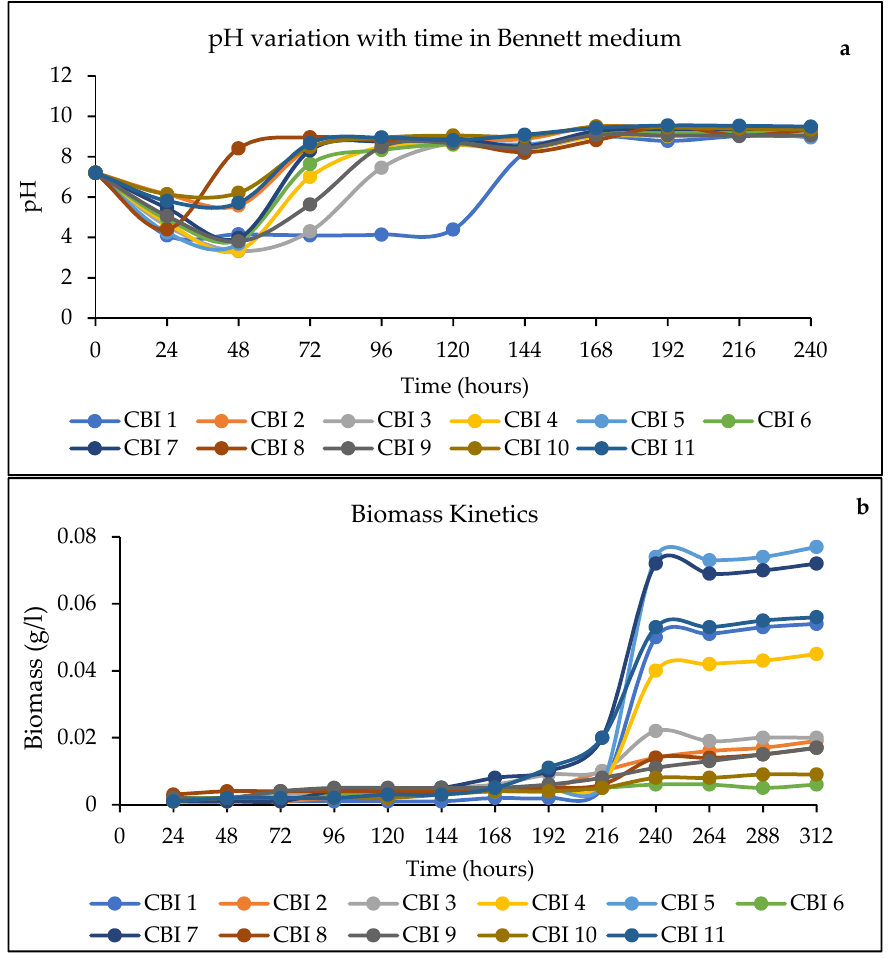
Figure 2. ( a ) Variations in pH of the different CBI samples in Bennett medium; ( b ) kinetics of population growth (biomass) of the different CBI samples.